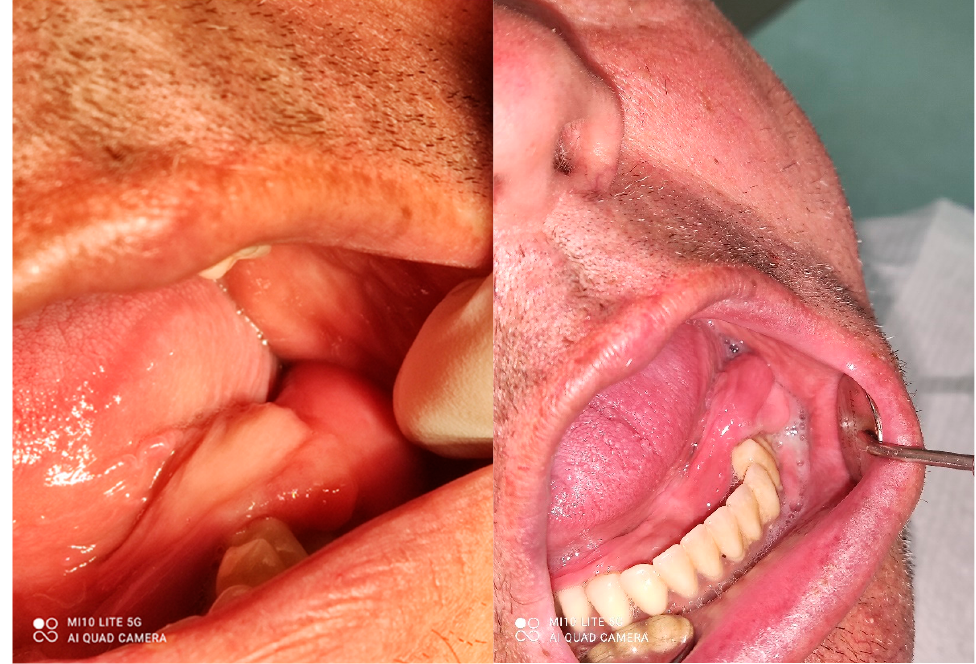
Figure 1. Clinical appearance of the mass during first visit.